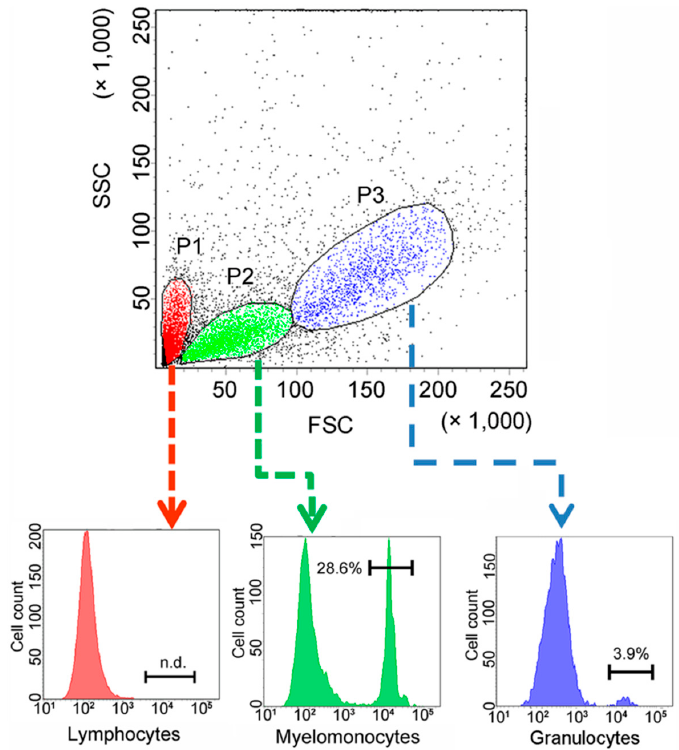
Figure 6. Cell-specific expression of CsCD209 determined by flow cytometry. Single cell suspension was prepared from head kidney and labeled with antibody against recombinant CsCD209 (rCsCD209) and Alexa Fluor 488-labeled Goat anti-mouse IgG. Dot plot (upper panel) demonstrates the distribution of cells in head kidney by light scatter: lymphocytes (red), myelomonocytes (green), and granulocytes (blue). Histogram shows the expression of CsCD209 in lymphocytes (lower left), myelomonocytes (lower middle), and granulocytes (lower right).